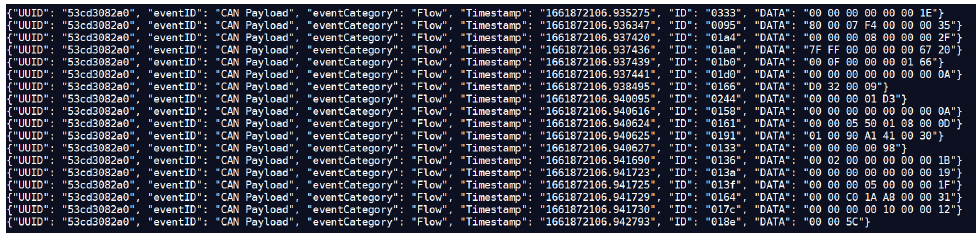
Figure 6. Messages generated by ICSim and transformed into JSON format by the TCU compo- nent.